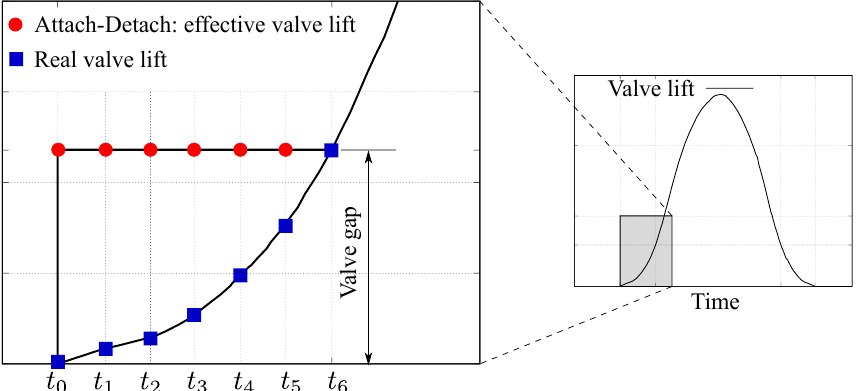
Figure 7. Examples of the effective numerical valve lift for the attach-detach technique.